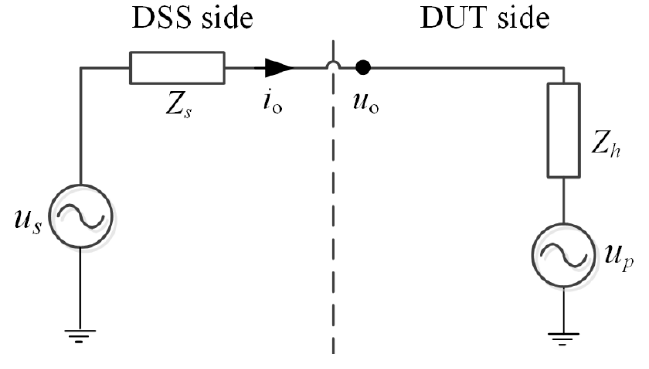
Figure 4. The naturally coupled system (NCS).